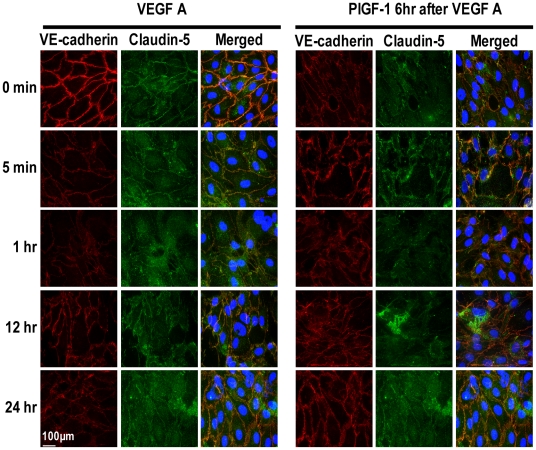
PlGF-1 stabilizes both AJs and TJs in vitro following VEGF-induced permeability.Representative pictures of confluent cultures of microvascular endothelial cells treated with VEGFA alone or VEGFA followed by hPlGF-1 6 hours later triple stained for VE-cadherin (red), claudin-5 (green) and nuclei (DAPI) and assessed at different times over 24 hours using confocal microscopy. VEGFA and hPlGF-1 were used at 100 ng/ml. Scale bar = 100 µm.